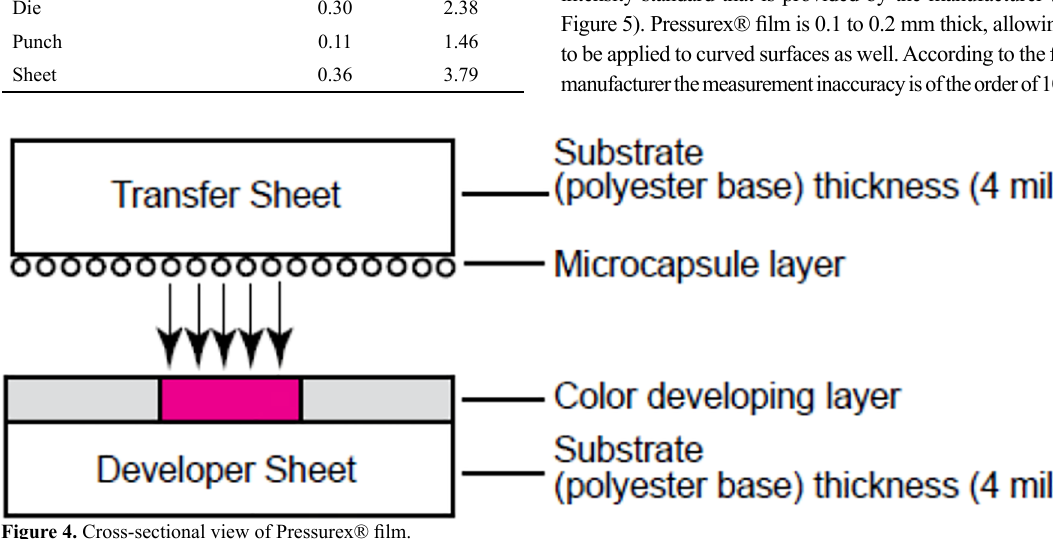
Figure 4. Cross-sectional view of Pressurex® film.